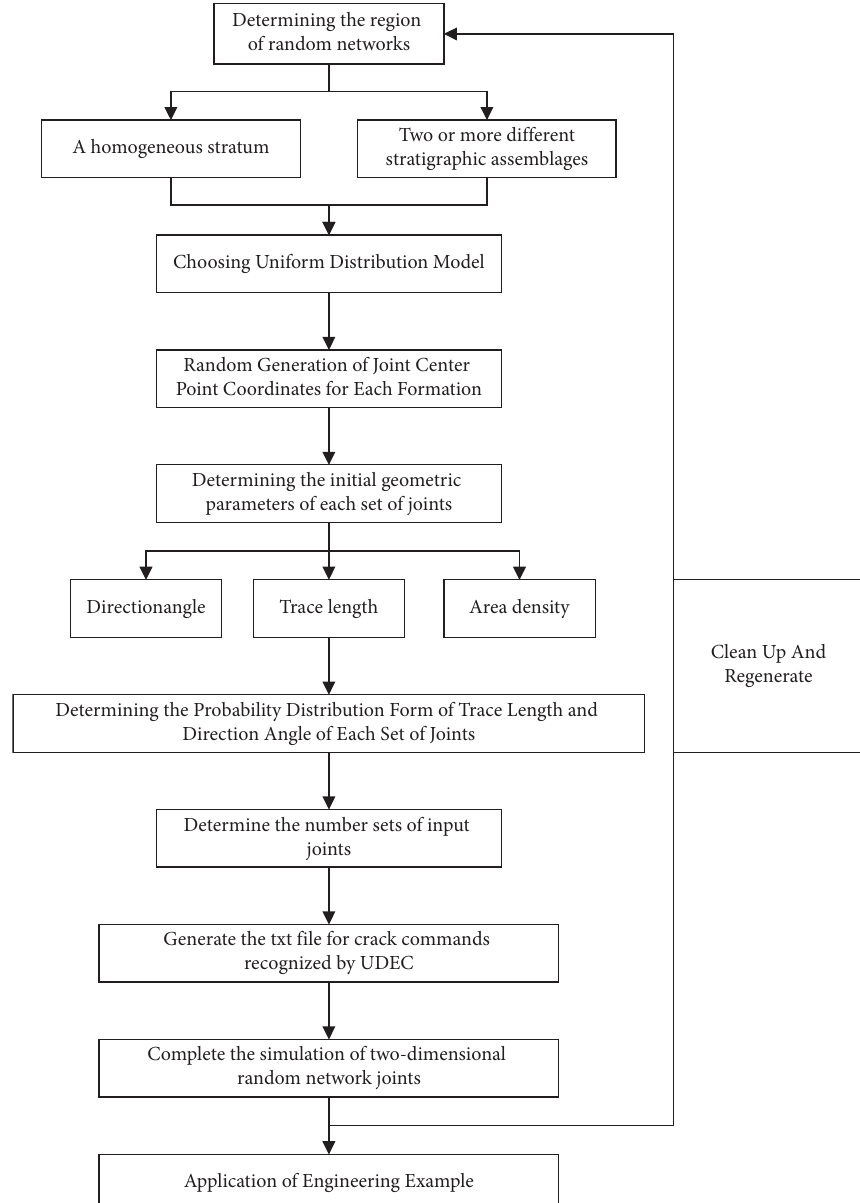
Figure 1: Te road map of 2-D random joint network generation